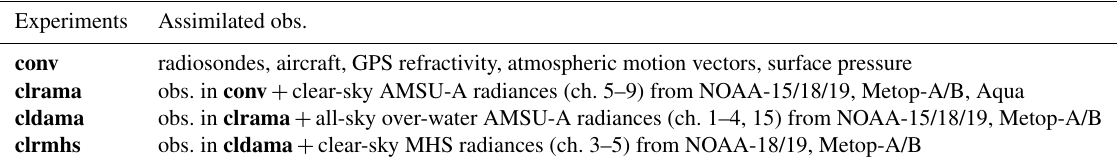
Table 1. Observations assimilated in the four cycling 3DEnVar experiments. Experiments Assimilated